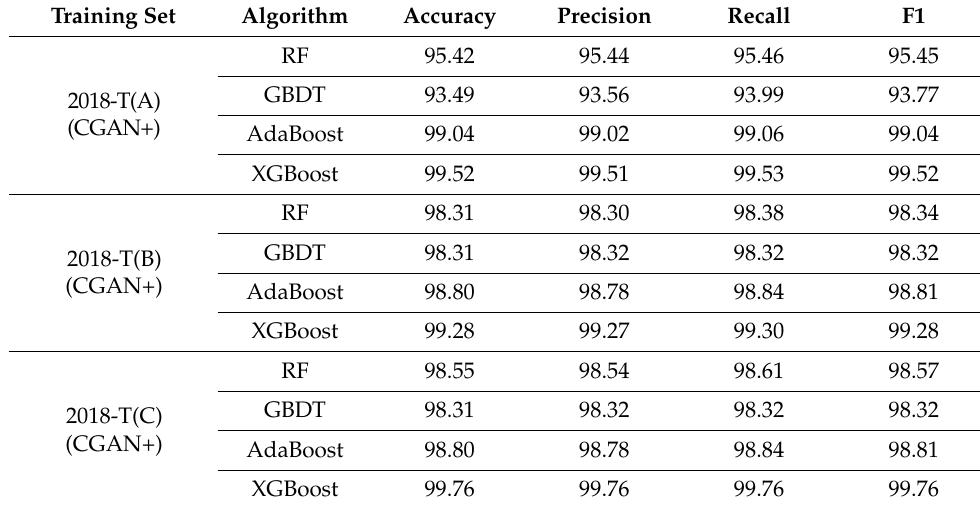
Table 2. Performance comparison of different algorithms using CGAN-enhanced sample sets (%). Training